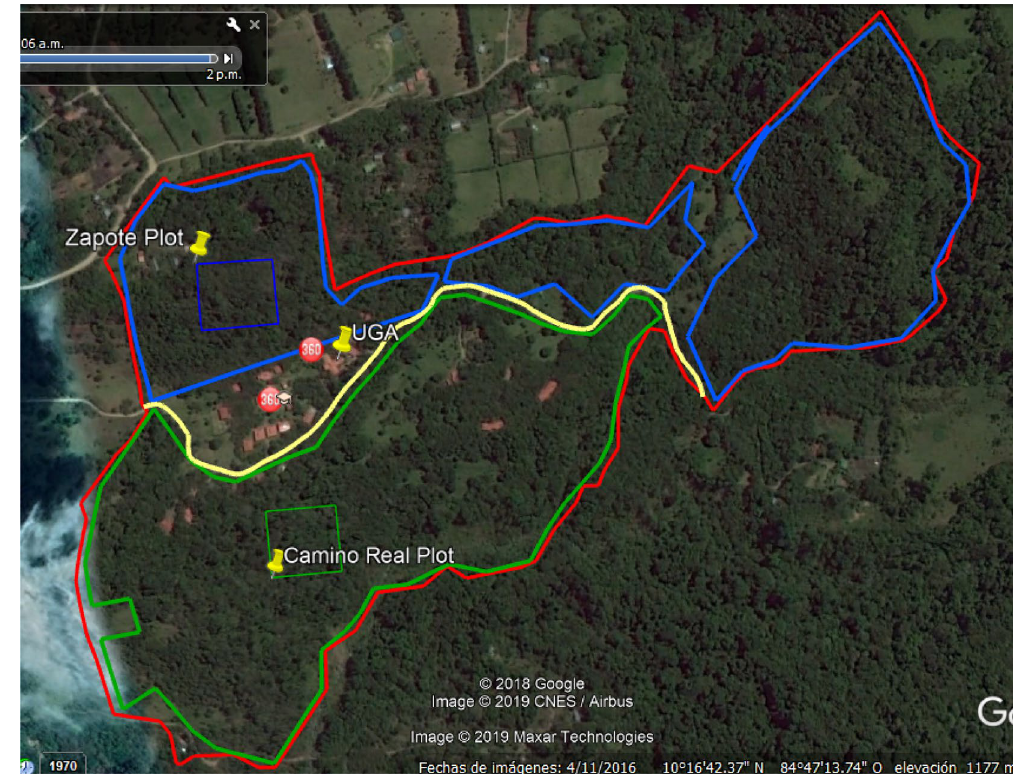
Figure 3. Map of the campus and location of Zapote and Camino Real Plots. Map of the campus outlined in red, the forest areas corresponding to Zapote in blue and Camino Real in green. (2018 Google, Image ©2019 Maxar